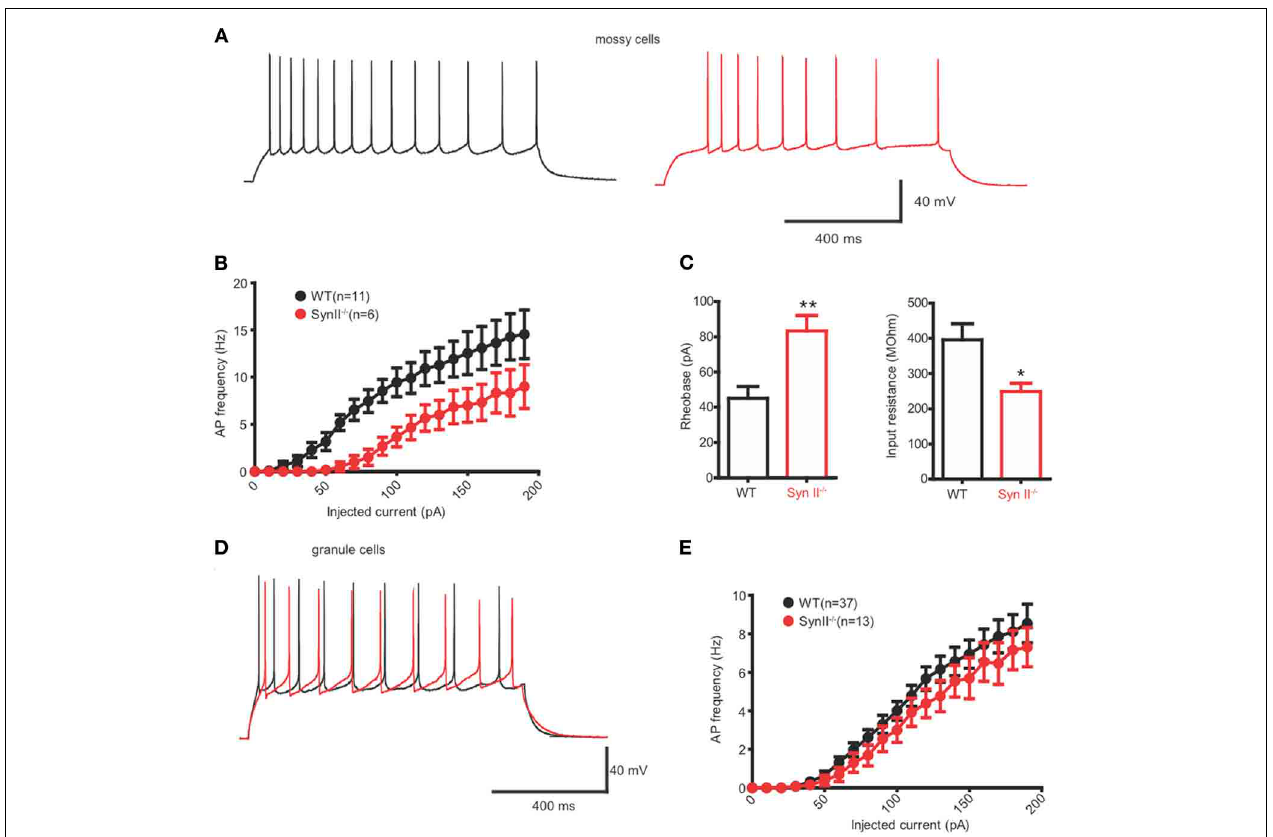
FIGURE 5 | Hilar mossy cells of pre-symptomatic Syn II − / − mice display decreased excitability. (A) Representative traces of whole cell current-clamp recordings from hilar mossy neurons in acute slices of WT (black) and pre-symptomatic Syn II − / − (red) mice. (B) Action potential (AP) frequency plotted as a function of the injected current for both genotypes.